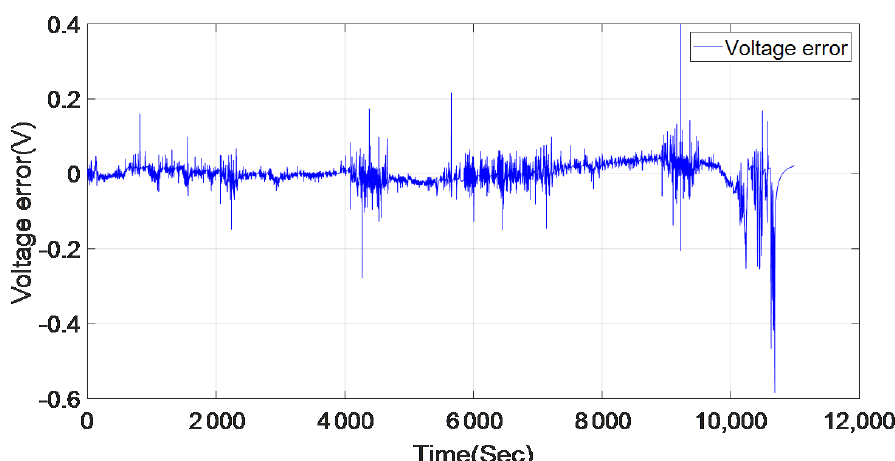
Figure 7. Measured minus simulated model